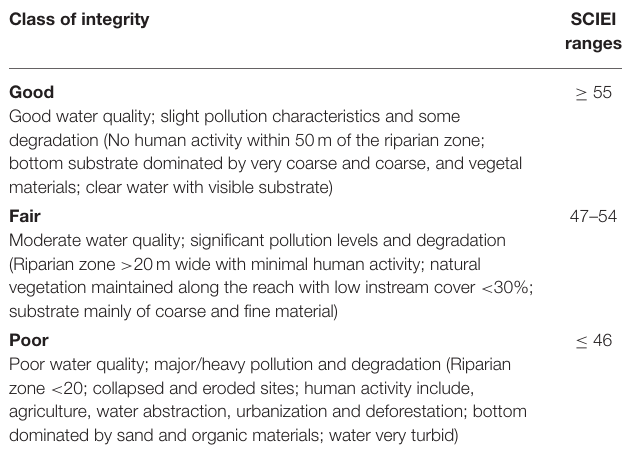
Class of integrity SCIEI